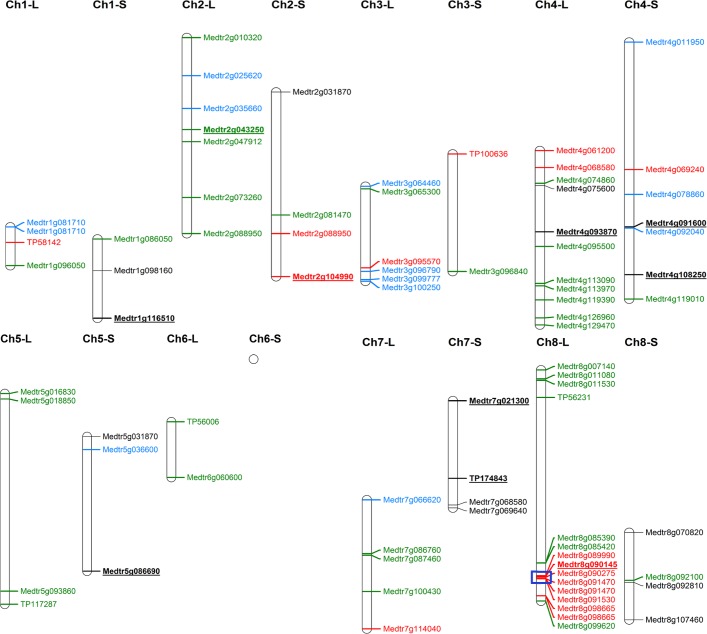
Physical map of annotated genes and markers associated with alfalfa leaf (L) and stem (S) quality traits.Blue, neutral detergent fiber; red, acid detergent lignin; black, crude protein; green, in vitro NDF digestibility at 24 hours. Major associations (whose definition is given in Table 3) are bold underlined. The blue box highlights a portion of chromosome 8 with high concentration of significant associations. Marker positions were based on the reference genome of M. truncatula Mt4.0v1.